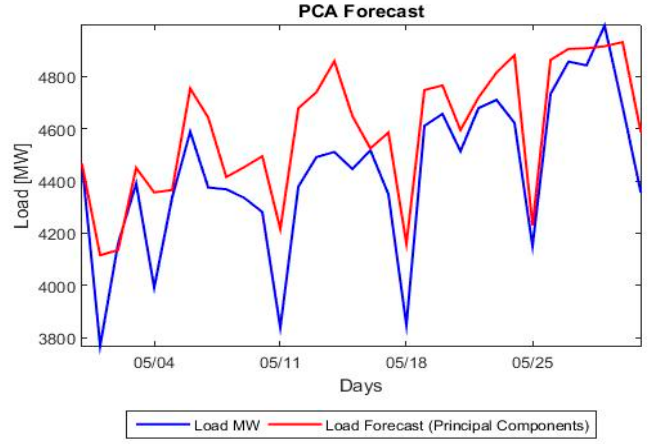
Figure 17. Principal component regression forecast for May 2014.